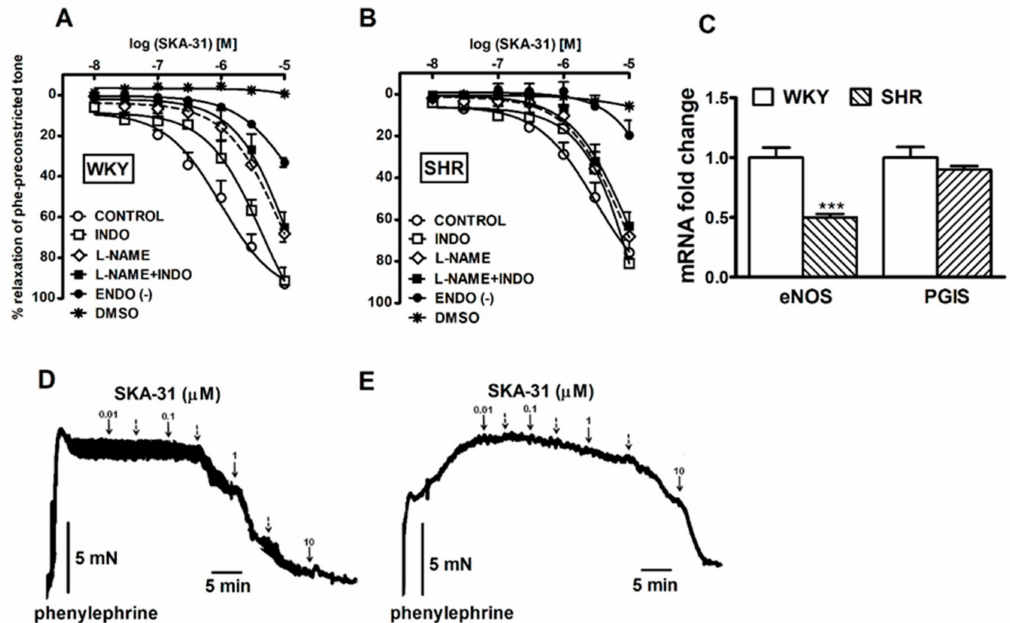
Figure 4. Influence of indomethacin (INDO, inhibitor of cyclooxygenase, COX, 10 µ M) and N ω -nitro- L -arginine methyl ester ( l -NAME, inhibitor of nitric oxide synthase, NOS, 100 µ M) given alone or together, or endothelium physical disruption on the vasorelaxant e ff ects of SKA-31 in the small mesenteric arteries (sMAs) from WKY ( A ) and spontaneously hypertensive (SHR) rats ( B ). RT-qPCR analysis of eNOS and PGIS in vessels isolated from SHR and WKY rats. Results shown as relative fold change in mRNA expression in SHR in comparison to WKY controls, where expression level was set as 1.0 ( C ). The representative original traces of the SKA-31 induced relaxation of sMAs derived from WKY ( D ) and SHR ( E ). Arrows show the moment of application of the particular concentrations of SKA-31. Broken arrows represent the following concentrations (from the left): 0.03, 0.3, 3 µ M, respectively. Results are expressed as a percentage of relaxation of the isometric contraction induced by phenylephrine (Phe). Mean ± SEM of n = 5–14 animals for each curve or mRNA levels. In a few cases, the SEM is smaller than or equal to the size of symbols. *** p < 0.001 compared to WKY. See Table 2 for statistical